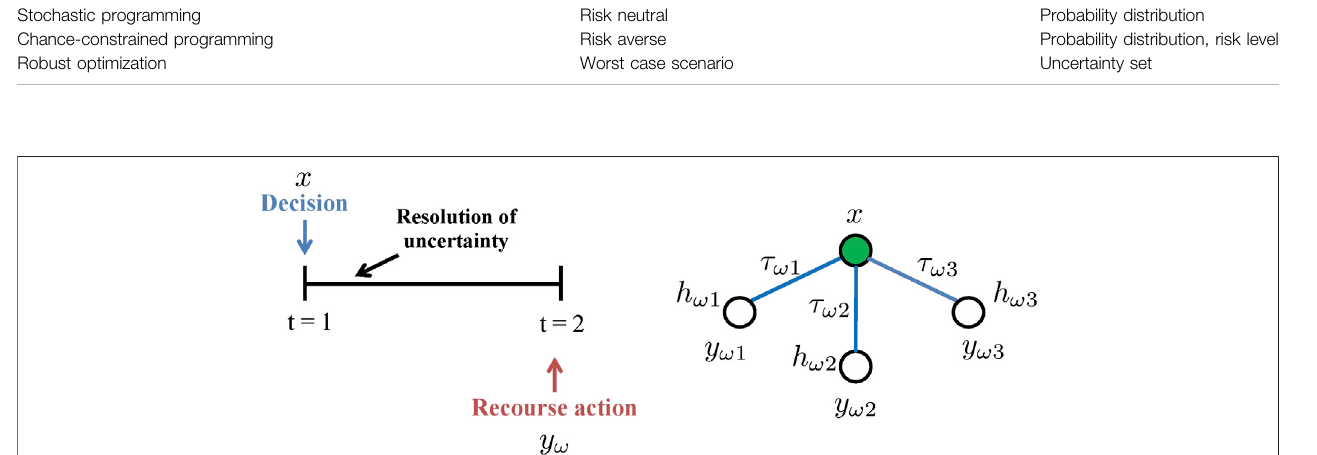
FIGURE 2 | Two-stage problem: conceptual representation (left); scenario tree (right) where x represents the fi rst stage decisions, y ω represents the stage two decisions for scenario ω . τ ω , h ω represent the probability and the uncertain right hand side of scenario ω , respectively.